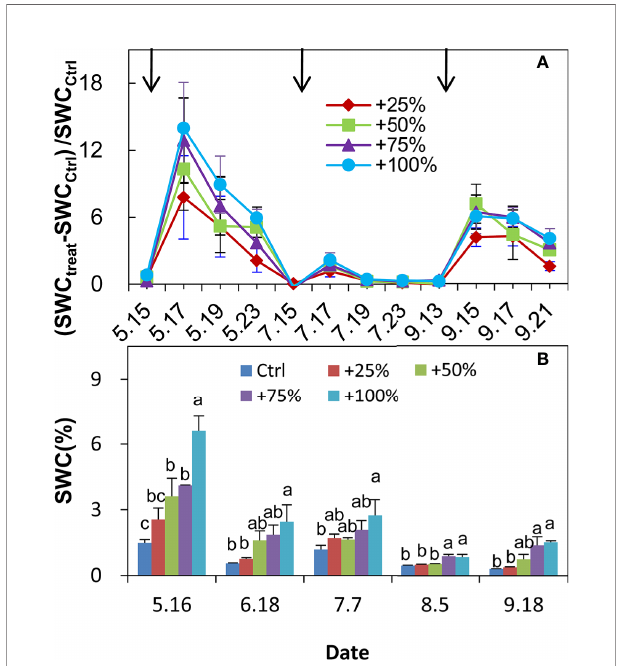
FIGURE 3 | Relative changes of 0 – 20 cm soil water content (SWC) compared with control (Ctrl) in +25, +50, +75, and +100% water addition treatment plots in spring (May), summer (July), and autumn (September) in 2012 (A) . Variation in 0 – 20 cm SWC during the growing season (May to September) of 2017 (B) . SWC Ctrl represents SWC in control plots. SWC treat represents the SWC in water addition treatment plots. Arrows in (A) represent the water addition treatment application time.